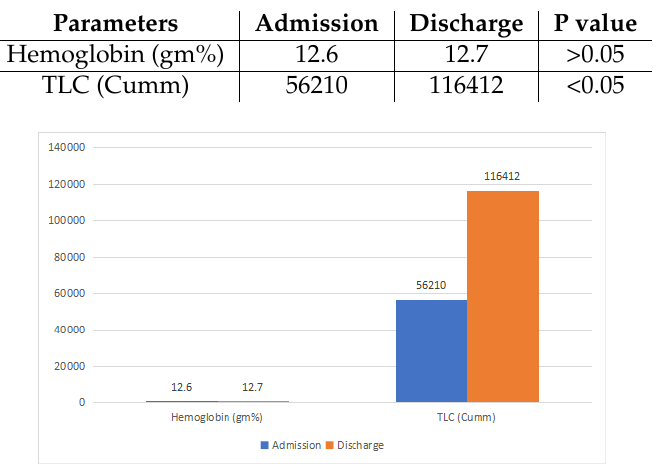
Table 3. Evaluation of laboratory parameters